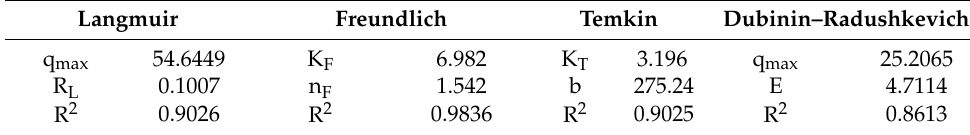
Figure 9. ( a ) Langmuir, ( b ) Freundlich, ( c ) Tembkin, and ( d ) D-R isotherm models for the adsorption of CIP on GA-MNPs. of CIP on GA-MNPs. Table 8. Isotherm models for the adsorption of CIP using GA-MNPs. Table 8. Isotherm models for the adsorption of CIP using